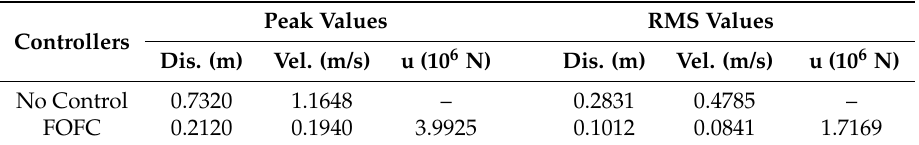
Table 1. Response peak and RMS values of the structure and control force under FOFC and no